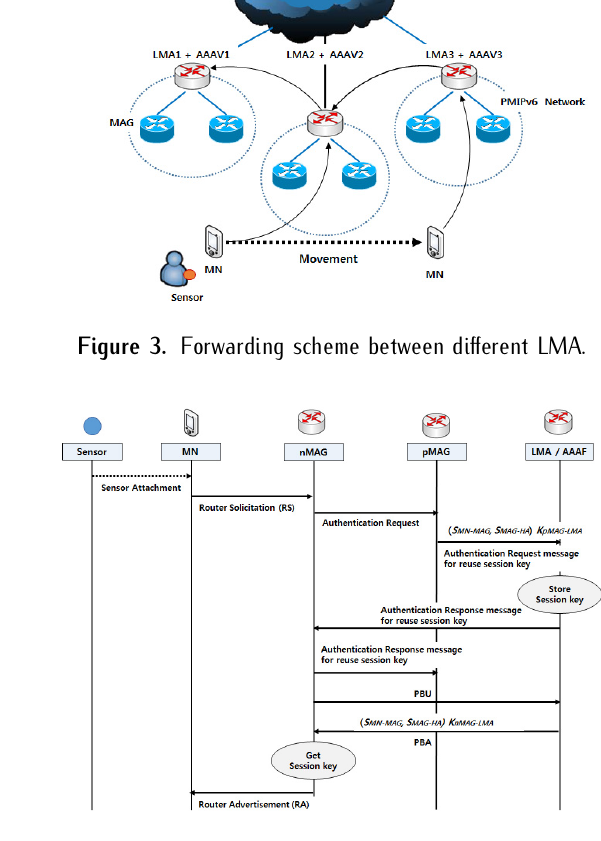
Figure 4. Intra-domain handover